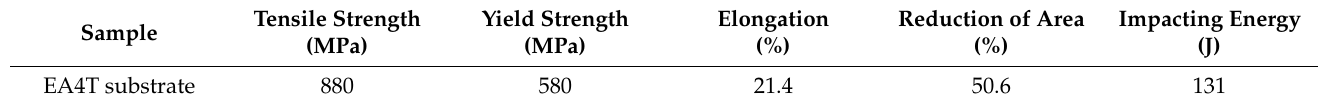
Table 2. Tensile properties and the U-notch impact energy for the EA4T steel.